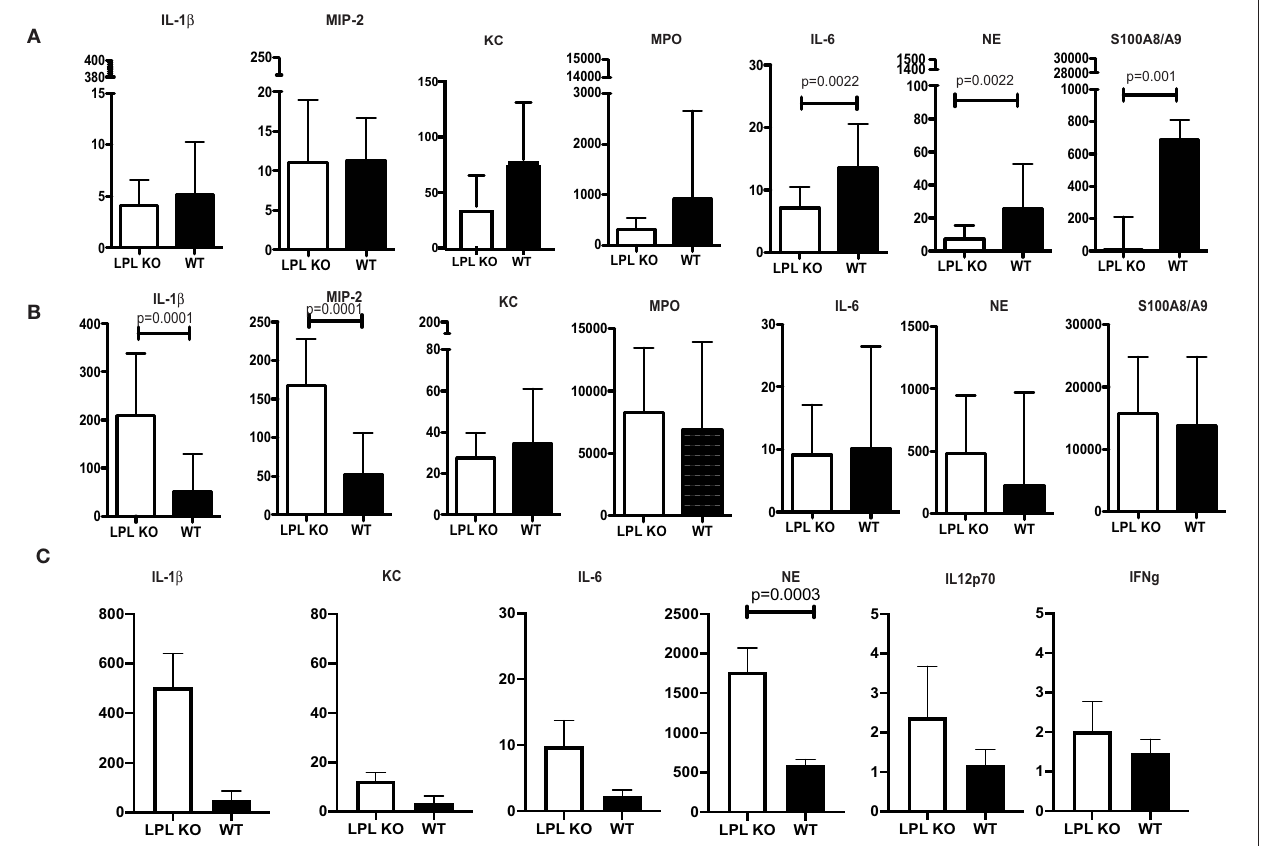
FIGURE 3 | Profiling of corneal inflammatory mediators shows altered inflammatory responses. (A) Corneal inflammatory profiles at 6h post-infection with P. aeruginosa 6294. (B) Corneal inflammatory profiles at 24h post-infection. (C) Corneal inflammatory profiles at 48h post-infection. Data plotted in all panels are from groups of 7LPL KO mice and 7 WT littermates mice that were infected with 5 × 10 5 CFU P. aeruginosa 6294 placed onto scratch-injured eyes. Corneas were harvested either at after infection, washed in F12 media, homogenized in PBS containing a mix of protease inhibitors and supplemented with 0.5% Triton to disrupt plasma membranes. The levels of cytokines in corneal lysates were measured using ELISA, p -values by Student’s t -test. Bonferroni correction for multiple comparisons p = 0.007. Data show significant alterations in NE levels indicative of changes in neutrophil trafficking.